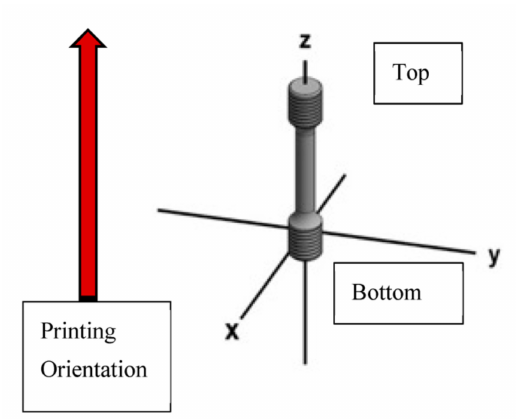
Figure 6. Machined tensile specimen sectioned at the top and bottom threaded sections for